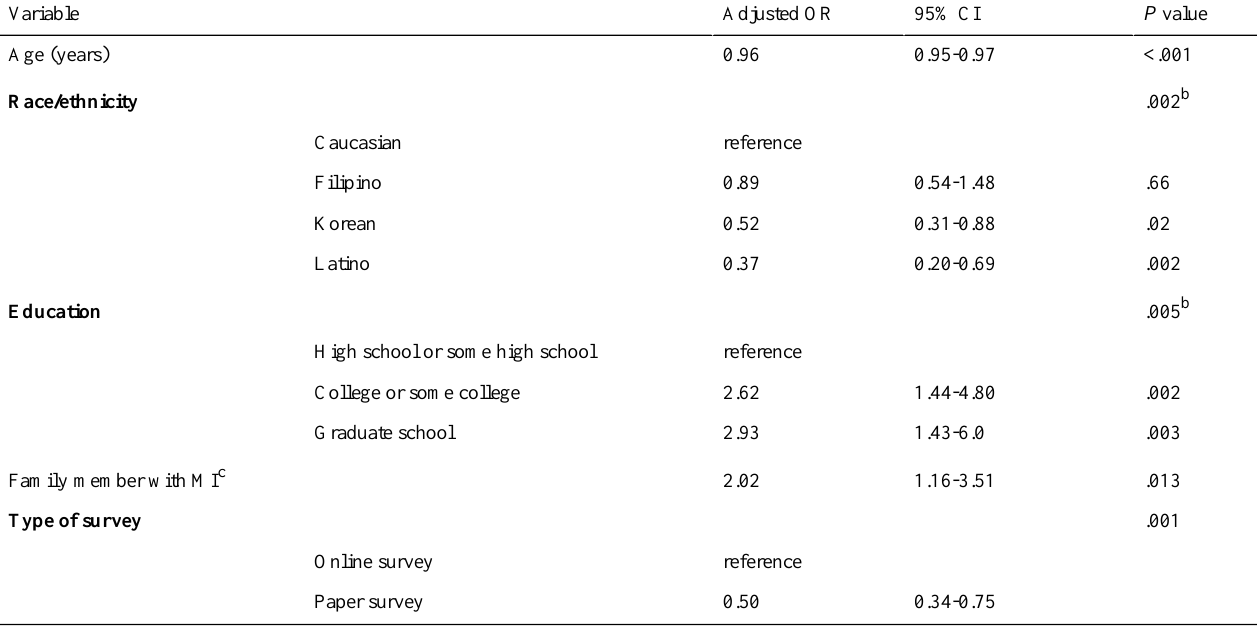
Table 3. Multivariate logistic regression model for factors predicting the download of mobile health apps (N=848).